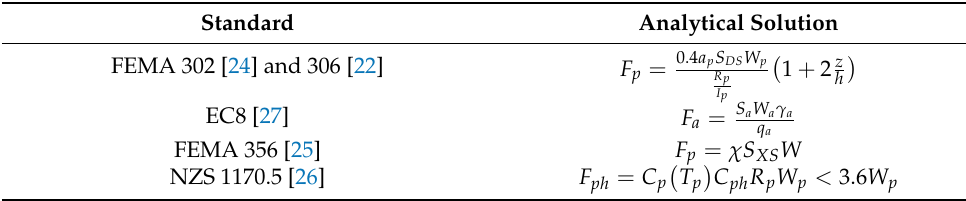
Table 5. Analytical solutions used to compute the out-of-plane demand of the infill walls.